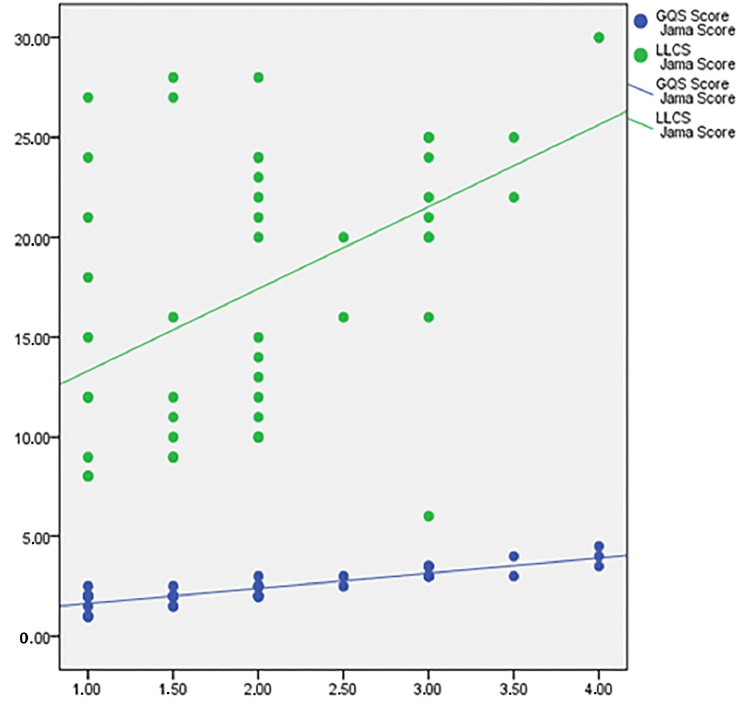
Figure 4. Relationship of JAMA score to other scores.